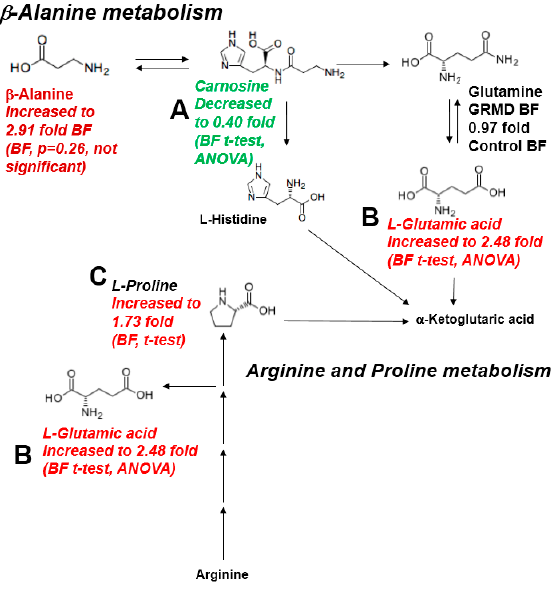
Figure 6. Significantly altered metabolites in the b-Alanine and Arginine/Proline metabolic pathways. ( A ) Carnosine decreased in BF by t -test and ANOVA; ( B ) Glutamic acid increased by in BF by t -test and ANOVA; ( C ) Proline increased in BF by t -test.